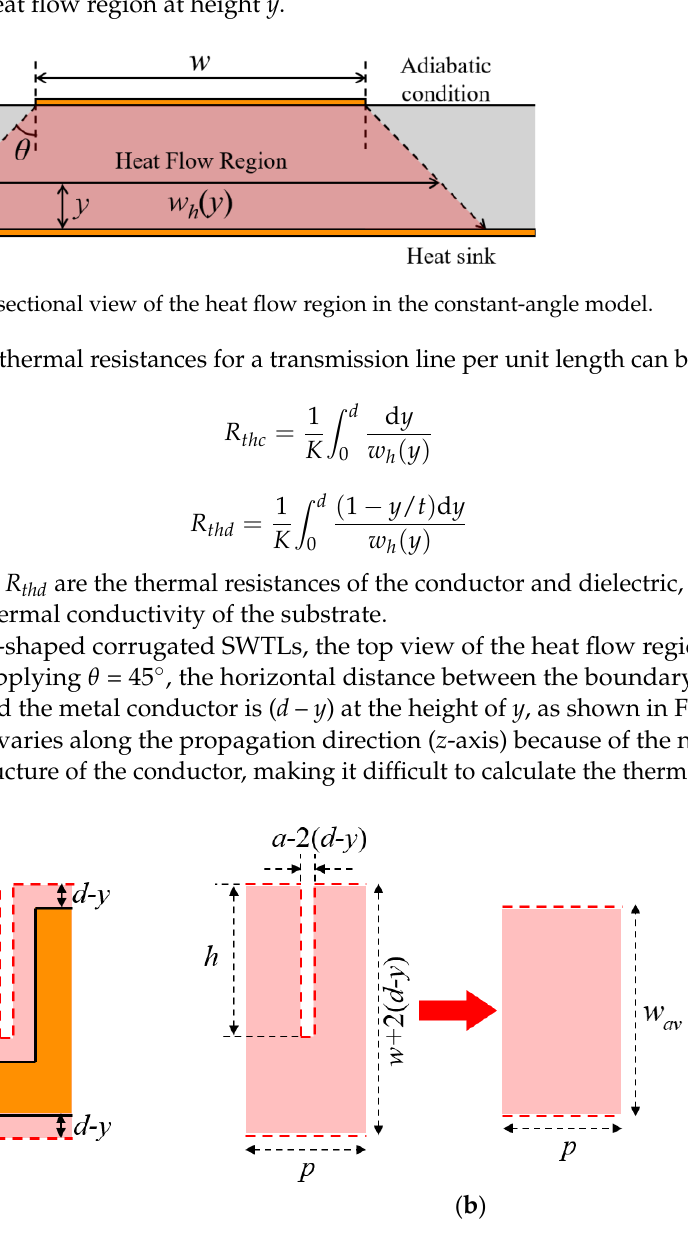
Figure 5. Top view of the heat flow region of U-shaped corrugated SWTL: ( a ) Boundary of the heat flow region; ( b ) schematic of w av ( y ).